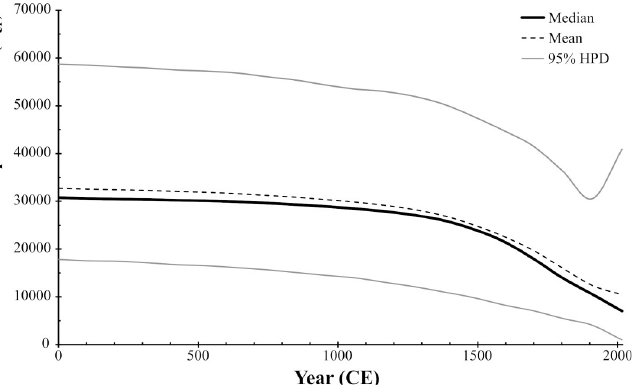
Fig 7. Bayesian skyline plot of the Chadian D . medinensis population over time. Derived from Chadian D . medinensis mitochondrial sequences (concatenated cytB-cox3-nd3-nd5 , sampled from 2014–2016). The x-axis is in years (0 to 2016 CE) and the y-axis is N (the product of the effective population size of female parasites and the eτ generation time). Assuming a generation time of 1 year, this is equivalent to the effective population size of female parasites N . Analysis assumed a strict molecular clock and mutation rate of 1.57 x 10 − 7 mutations per site per ef